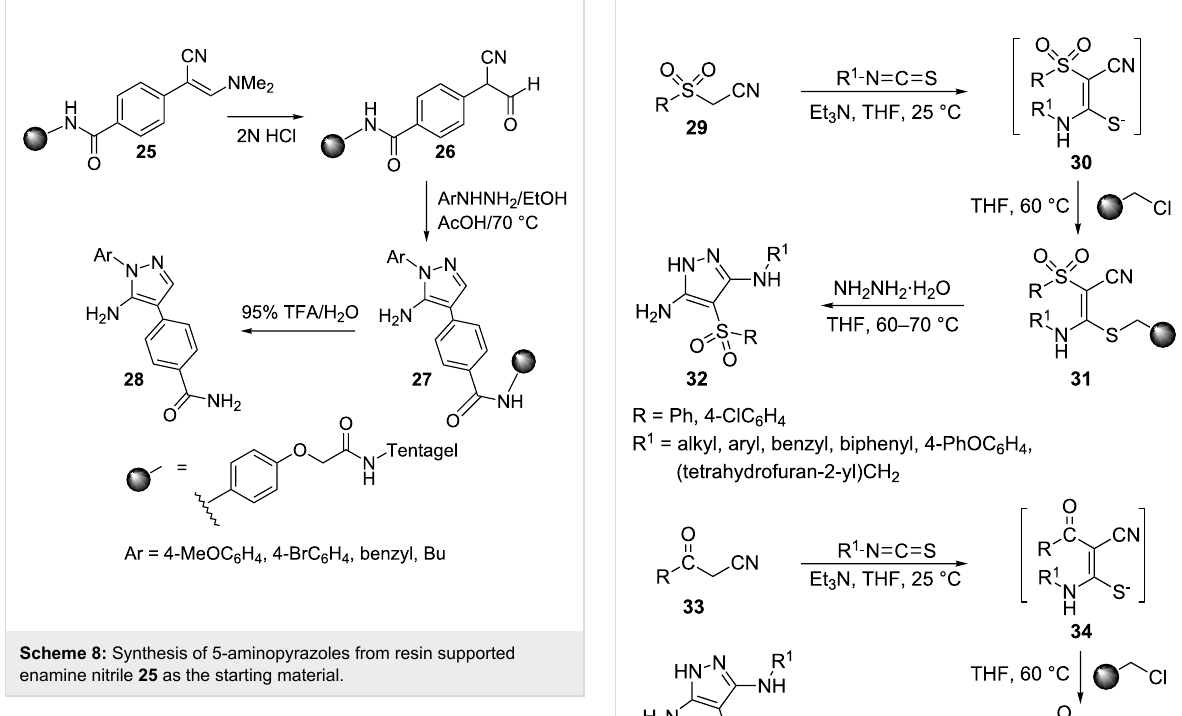
was reported which involved a base-promoted condensation of a 2-sulfonyl- or a 2-carbonyl-acetonitrile derivative ( 29 or 33